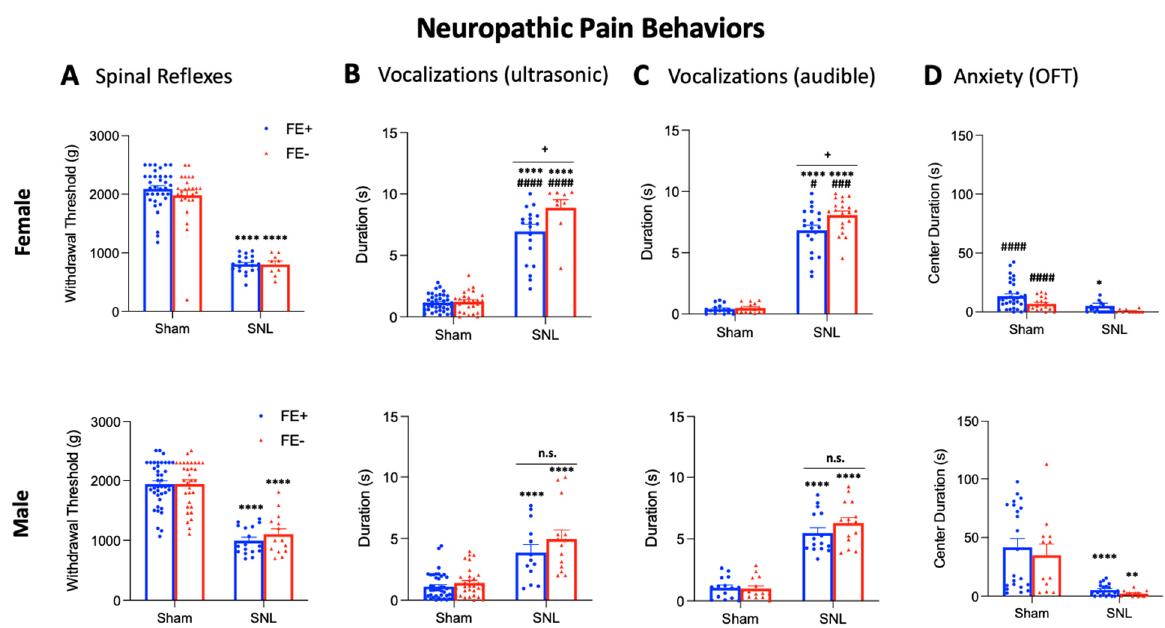
Figure 4. Inter-individual and sex differences in neuropathic pain-related behaviors of FE+ and FE − rats. ( A ) Mechanical thresholds tested in sham and chronic neuropathic SNL rats (4 weeks post-induction) showed no significant differences between FE − (female, n = 26; male, n = 32) and FE+ (female, n = 35; male, n = 40) sham rats or between FE − (female, n = 9; male, n = 14) and FE+ (female, n = 20; male, n = 17) SNL rats, but SNL FE − and FE+ rats had significantly lower withdrawal thresholds than their sham controls. **** p < 0.0001, ANOVA with Bonferroni post hoc tests (see the “Results” section). ( B , C ) Duration (s) of of ultrasonic and audible vocalizations, respectively, evoked by a brief (10 s) noxious (1500 g/6 mm 2 ) mechanical compression of the affected hindpaw. Significant differences in ultrasonic and audible vocalizations were found between female FE − ( n = 15) and FE+ ( n = 20) SNL rats but not between male FE − ( n = 15) and FE+ ( n = 15) SNL rats or between FE − (female, n = 26; male, n = 32) and FE+ (female, n = 38; male, n = 41) sham rats. For both sexes, SNL rats had significantly increased vocalizations compared to their sham controls. n.s.: non-significant; + p < 0.05; # p < 0.05; ### p < 0.001; #### p < 0.0001; **** p < 0.0001, ANOVA with Bonferroni post hoc tests (see the “Results” section). ( D ) Center duration (s) in the OFT was significantly lower in FE − (female, n = 9; male, n = 13) and FE+ (female, n = 20; male, n = 20) SNL rats compared to their FE − (female, n = 19; male, n = 12) and FE+ (female, n = 33; male, n = 22) sham controls. No differences were found between FE − and FE+ rats in the sham or SNL groups for either sex. #### p < 0.0001; * p < 0.05; ** p < 0.01; **** p < 0.0001, ANOVA with Bonferroni post hoc tests (see the “Results” section). Bar histograms show means ± SEM. FE: fear extinction; OFT: open field test; SNL: spinal nerve ligation. Asterisk (*) indicates comparison to untreated group; plus sign (+) indicates comparison between phenotypes; pound sign (#) indicates comparison between sexes.